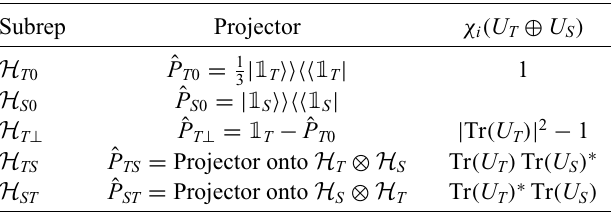
TABLE I. Subrepresentations of the standard representation for groups that preserve the triplet and singlet subspaces, and their corresponding projectors and